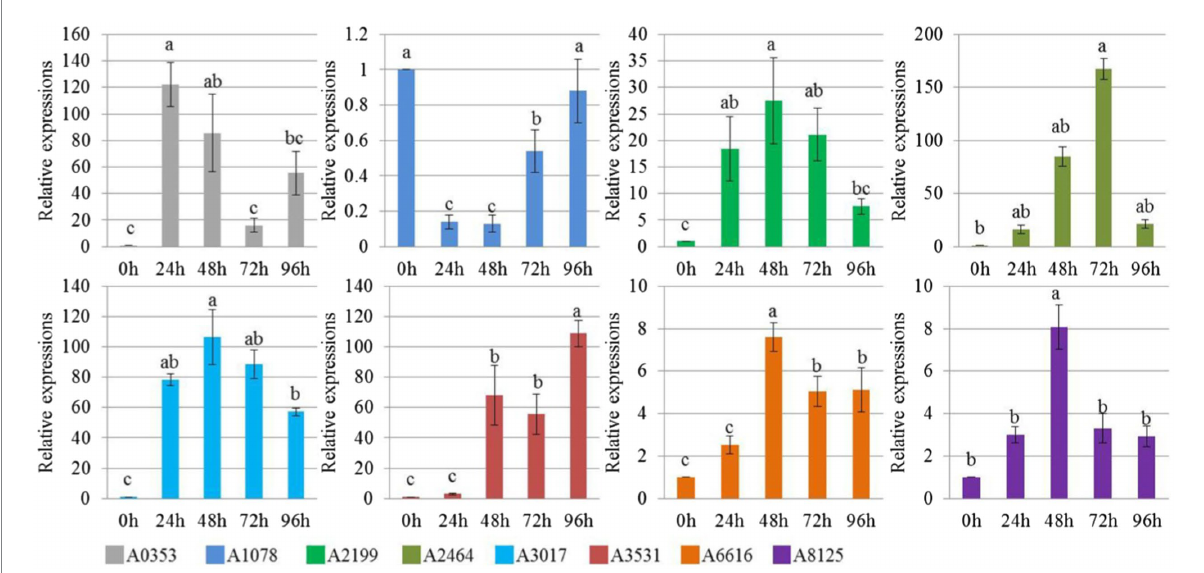
FIGURE 4 Relative expression level of Setosphaeria turcica f. sp. zeae specific effector coding genes at different infection periods postinoculation. Error bars represent means ± SE of three repeated experiments ( n = 3). Different letters indicate significant differences ( p < 0.05). A0353 encodes carbohydrate binding module family 18 protein; A1078 encodes glycoside hydrolase family 20 protein; A2199 encodes carbohydrate esterase family 1 protein; A2464 encodes glycoside hydrolase family 7 protein; A3017 encodes Argonaute/Dicer protein PAZ; A3531 encodes glycoside hydrolase family 62 protein; A6616 encodes glycoside hydrolase family 16 protein; A8125 encodes glycoside hydrolase family 10